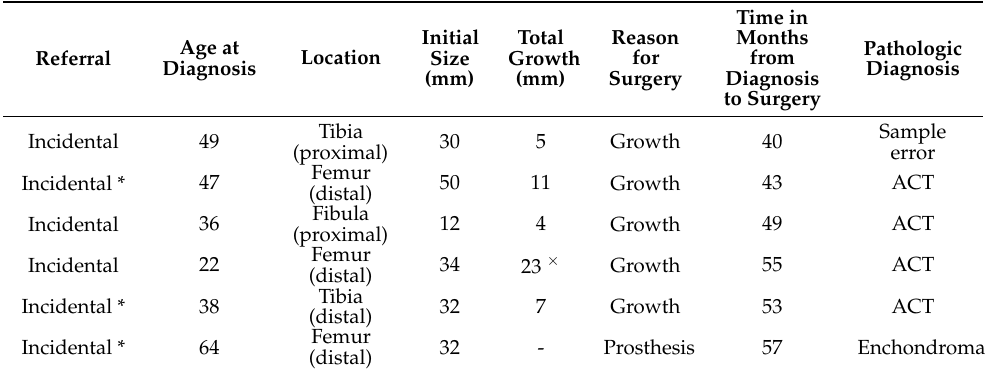
Table 3. Operated